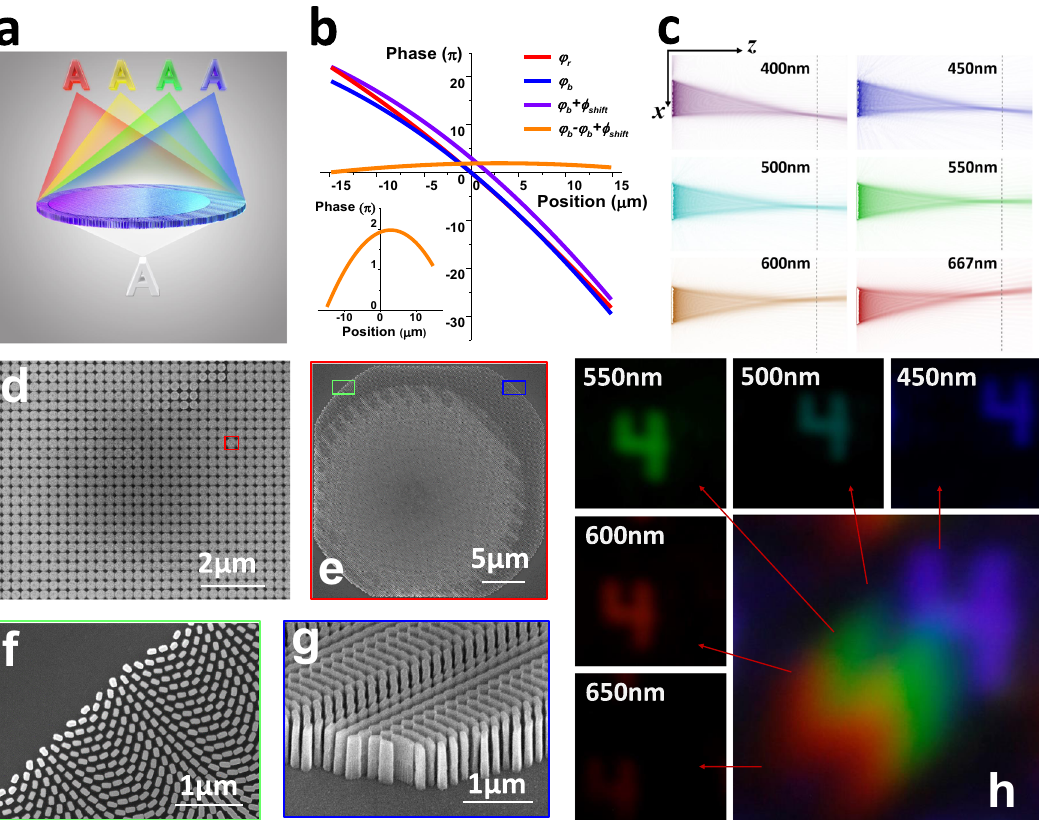
Fig. 1 The details of transversely dispersive metalens array. a Schematic of the transversely dispersive metalens. b Phase distributions at different wavelengths and phase compensation produced by the metalens. Inset shows the required phase compensation of the metalens. c Simulated focal spot intensity pro fi le for different wavelengths. d Scanning electron microscope (SEM) image of the fabricated metalens array. e Top view of the red region in ( d ) (single metalens). Zoomed-in SEM image ( f ) of the green region in ( e ). Tilted view ( g ) of the blue region in ( e ). Image of a letter “ 4 ” by the metalens with a white light illumination with a transmission window of 450nm – 650 nm is shown in ( h